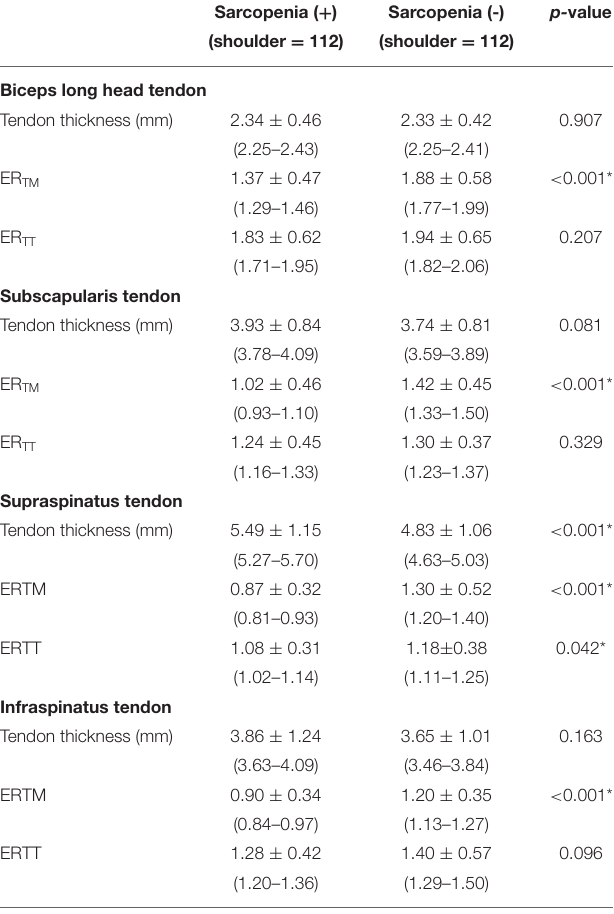
TABLE 2 | Quantitative measurement of rotator cuff tendon complex in participants with and those without sarcopenia. Sarcopenia ( + ) Sarcopenia